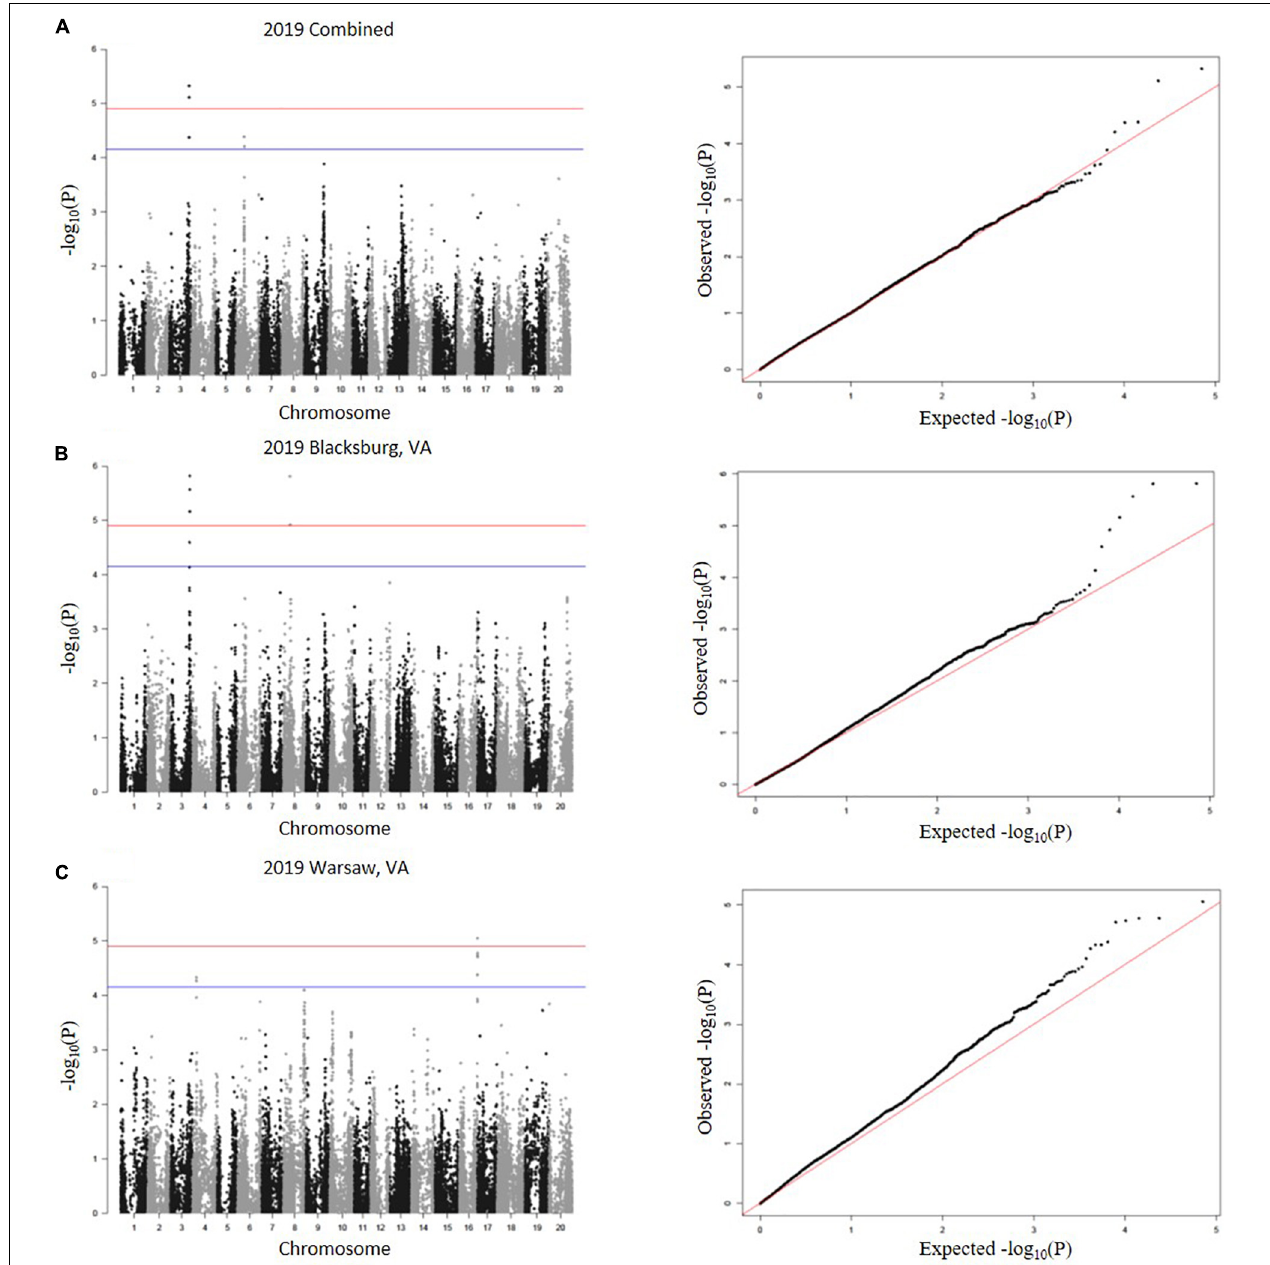
FIGURE 4 | SNP associations for 2019 environments, (A) combined, (B) Blacksburg, VA, (C) Warsaw, VA are displayed in Manhattan plots with chromosomes in alternating colors, significance threshold-log 10 (P) > 4.91 and suggestive threshold-log 10 (P) > 4.16. Each respective QQ plot displays observed-log 10 (P) against expected-log 10